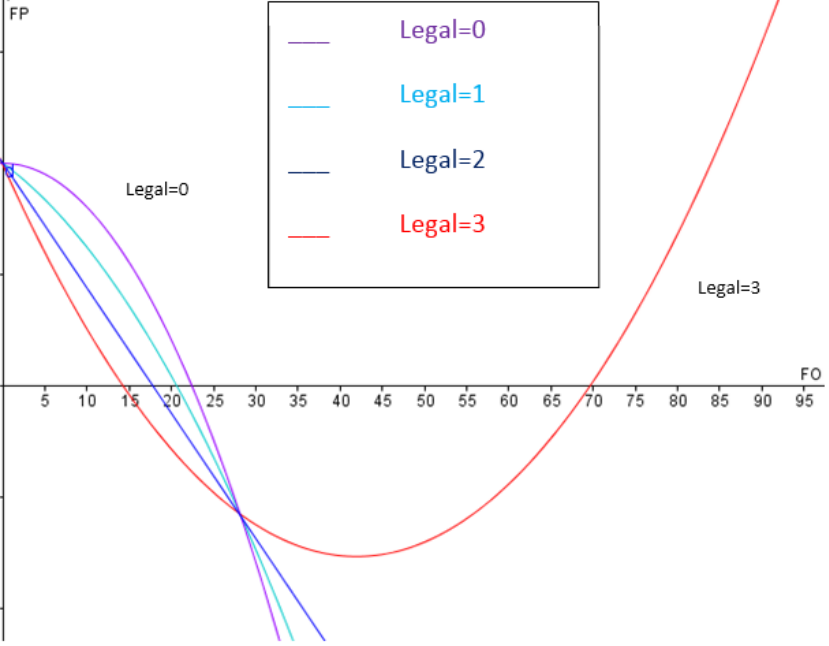
Figure 5. Significant Interactions between Family Ownership and Legal Provision. The negative moderation effects of Legal Provision changes the direction of inverted U-shaped relationship between Family Ownership and Firm Performance into a U-shape.